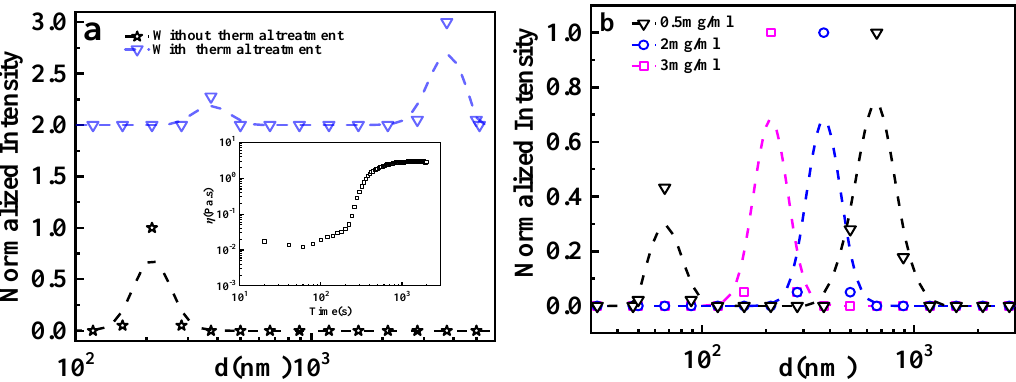
Figure 1. ( a ) Size distribution at 10 °C of 3 mg/mL chitosan − grafted − polyacrylamide 1 (GPAM1) solutions (0.01 M HAc) without and with a thermal treatment of holding at 40 °C for 3 min; inset displays the viscosity evolution of 3 mg/mL GPAM1 solutions with 0.01 M HAc at 40 °C. ( b ) Dependence of size distribution for GPAM1 solutions with 0.01 M HAc on concentration at 10 °C.